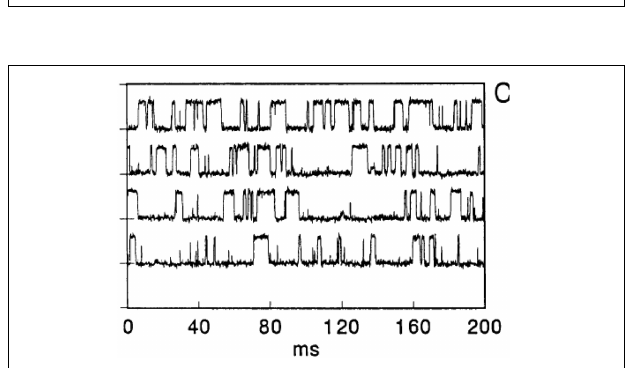
FIGURE 2 | Binary gating from patch pipettes and silicone seals. From Sachs and Qin